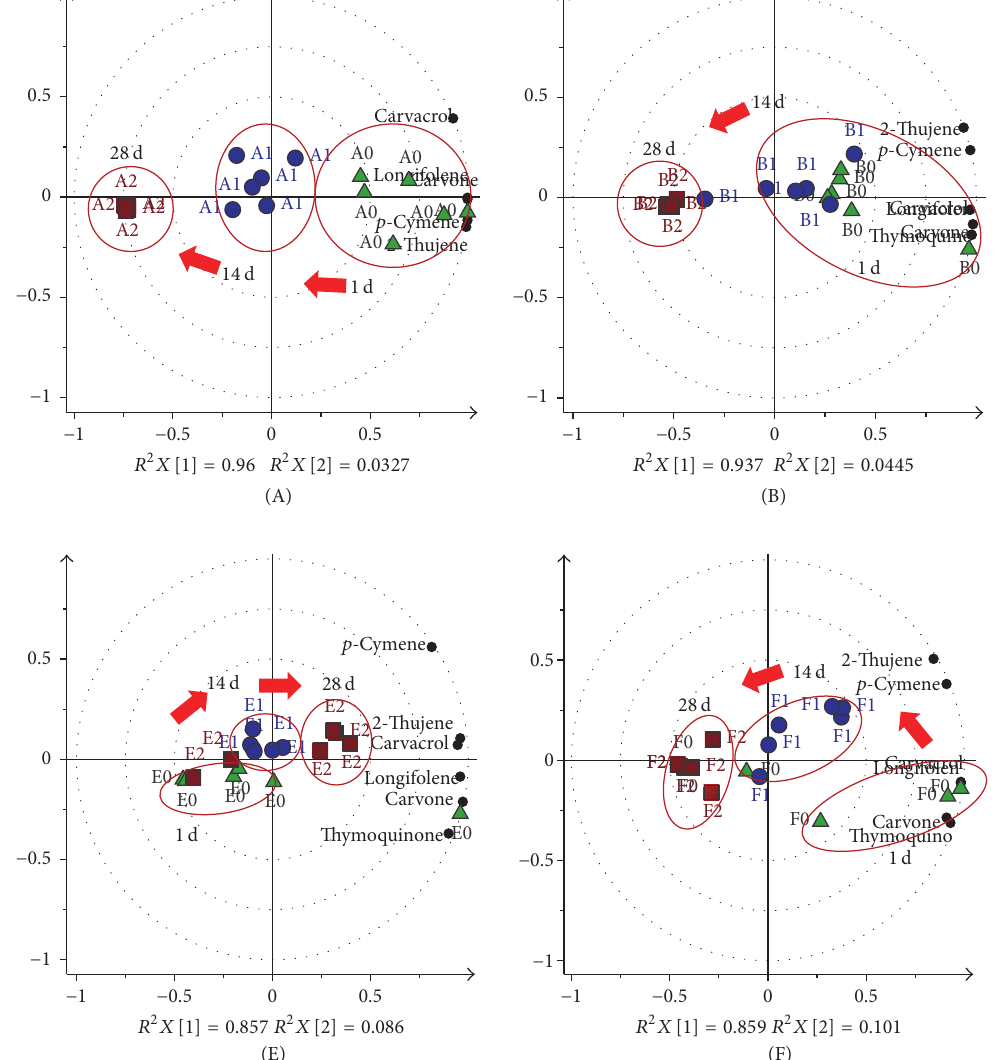
Figure 2: The biplot model of the principle component analysis (PCA) for storage to determine the effects of air on the seeds; 1st (green triangle), 14th (blue circle), and 28th (red square) day. The smaller black circles are those identified compounds from the